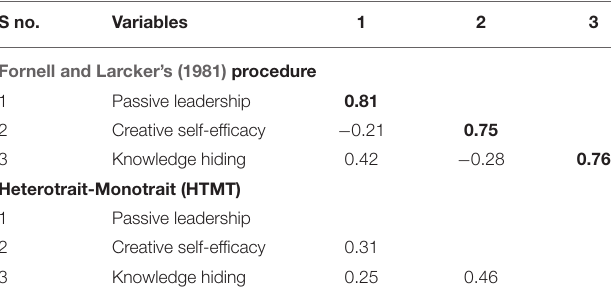
TABLE 2 | Discriminant validity.